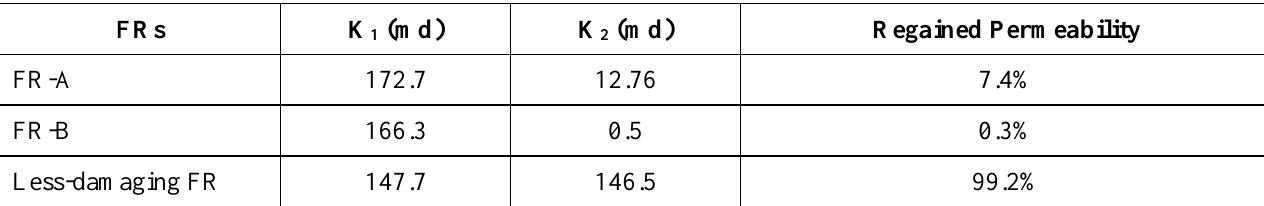
Table 7—Coreflood results comparison between less-damaging FR to common commercial FRs without breakers.